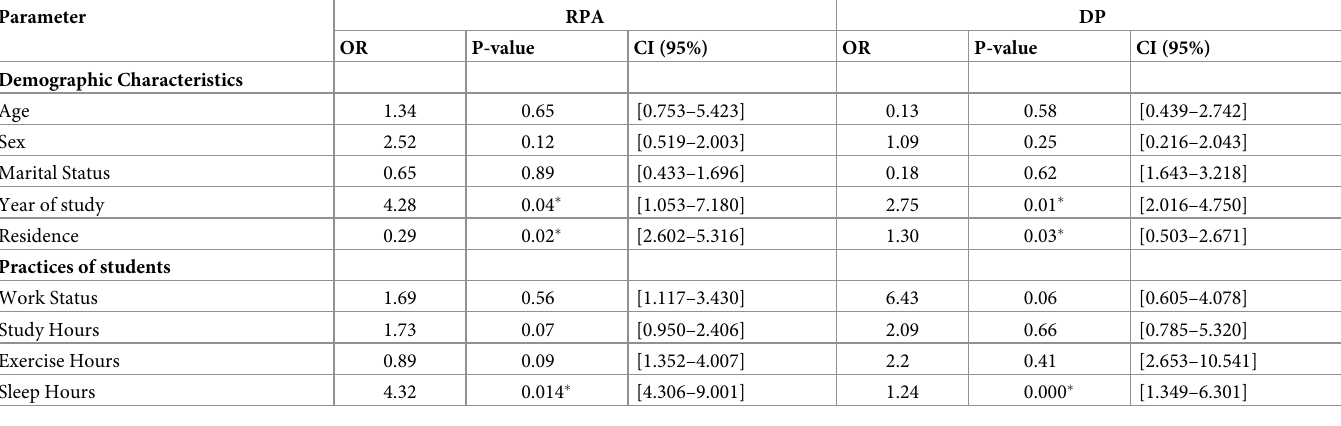
Table 8. Logistic regression analysis for burnout subscales, students’ demographics and student practices.